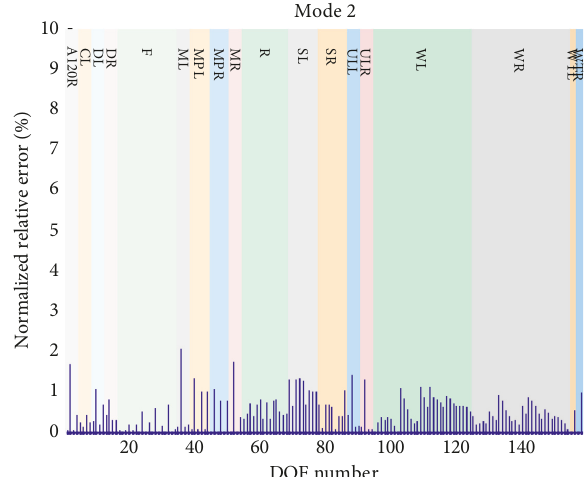
Figure 14: Normalized error location on F-16 for configuration 3 mode-2.